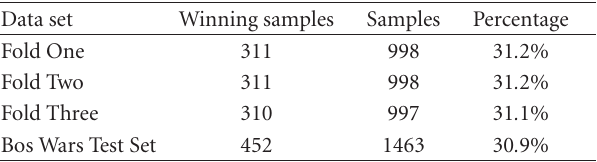
Table 3: Number of winning samples for each fold of the Bos Wars Training Set and the number of winning samples in the Bos Wars Test Set.